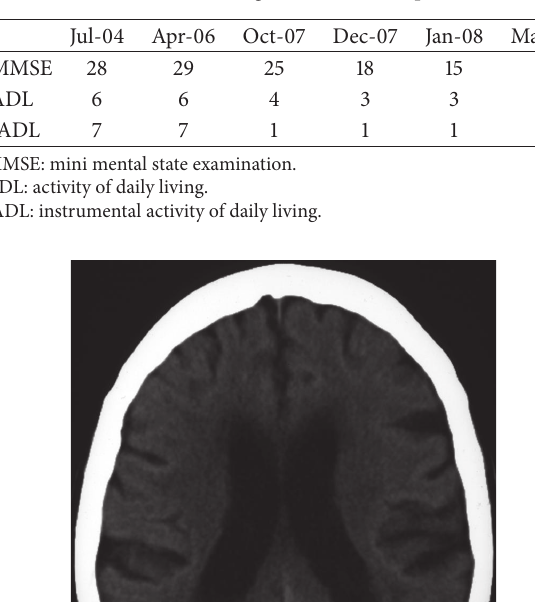
Table 1: Longitudinal follow-up.